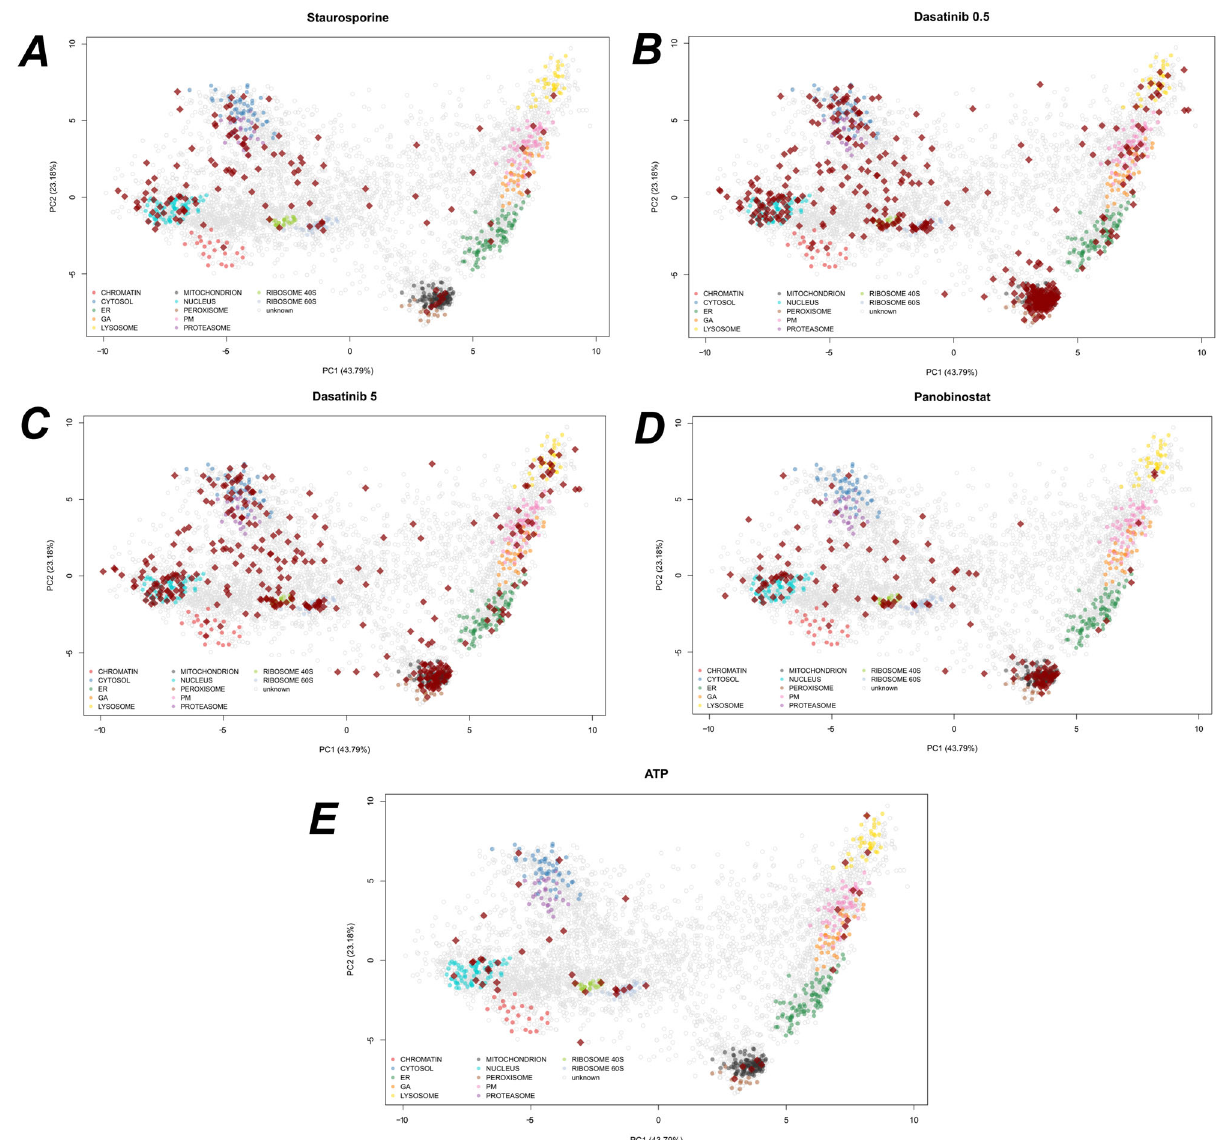
Fig. 6 Subcellular localisations of proteins deviating from sigmoid behaviour. A – E PCA plots of U-2 OS hyperLOPIT data 95 , showing the top two principal components. Each pointer is a protein and marker proteins for each subcellular niche are coloured. Dark red diamonds denote proteins that were deemed to have non-sigmoid behaviour from TPP data. Each panel represents a different TPP dataset for the projected proteins. HyperLOPIT experiments are from biological triplicates with using a total of 57